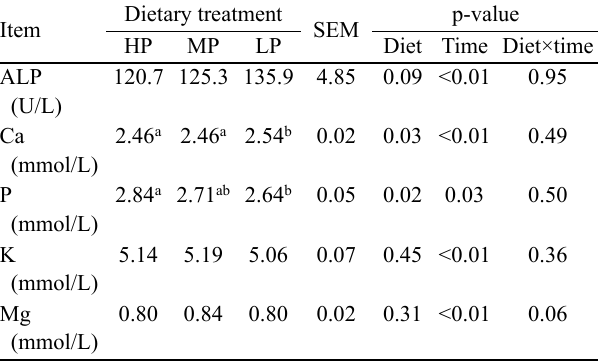
Table 4. Effect of different dietary phosphorus (P) on serum biochemical parameters of 8- to 10-month-old Holstein heifers Item